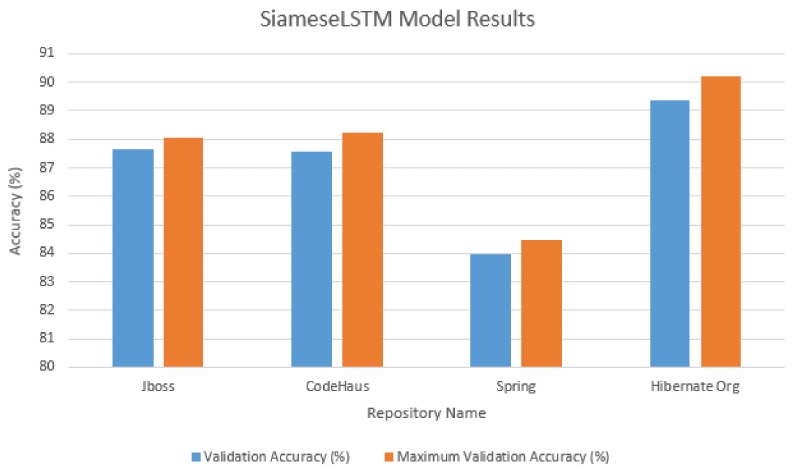
Figure 8. Model results from the deep learning model (Siamese LSTM) used as part of the conducted experiment across the four JIRA issue tracking repositories. Please see Appendix B for the detailed graphs produced by the model upon training for 50 epochs. Full model accuracy and loss versus the four handled issue tracking system (ITS) repositories are also illustrated on Figure A1 of Appendix